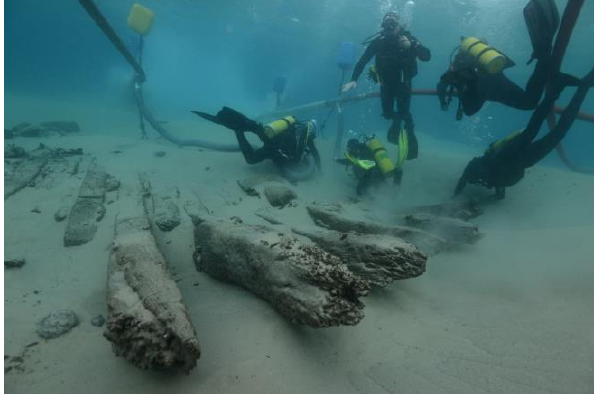
Figure 3: The shipwreck being excavated in December 2017 (photo: Nicolas Ponzone/Caesarea Shipwreck